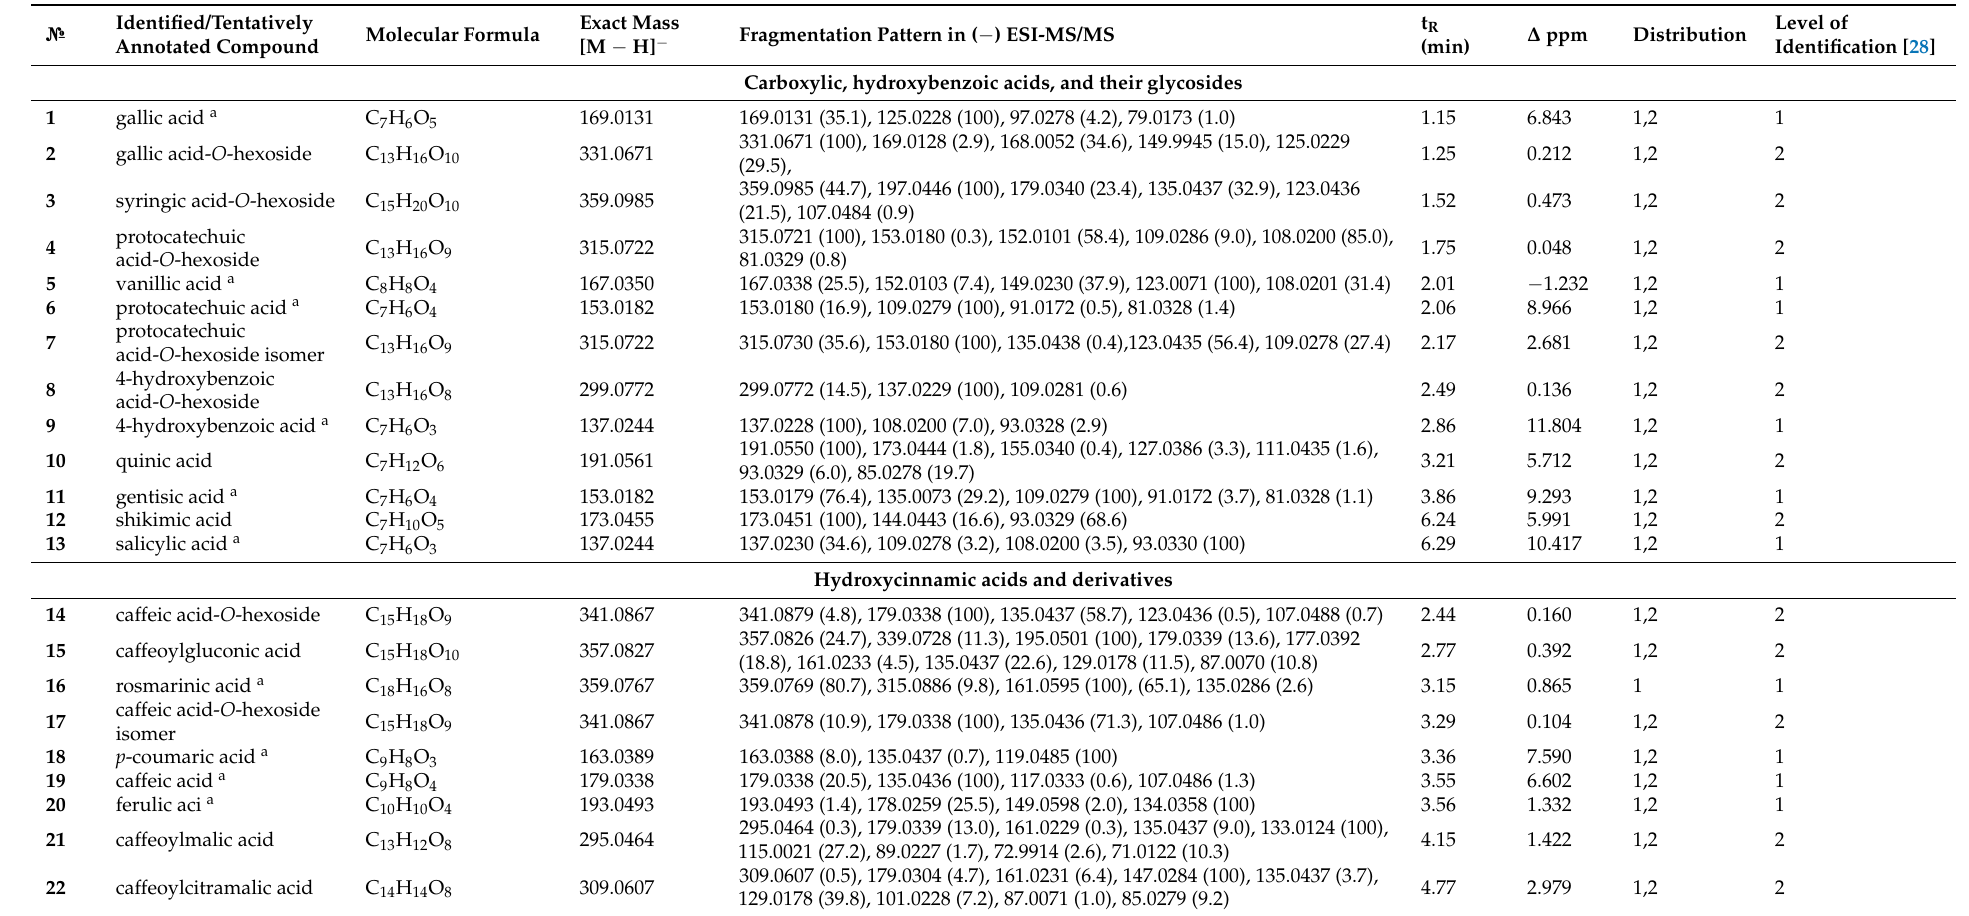
Table 1. Specialized metabolites in Cicerbita alpina